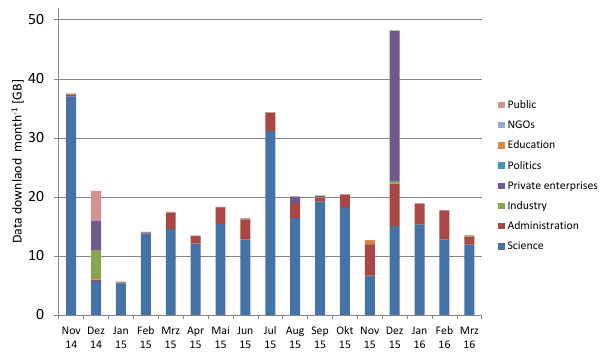
Figure 5. COSYNA data download sorted by user categories (November 2014 to March 2016; data provided by G.